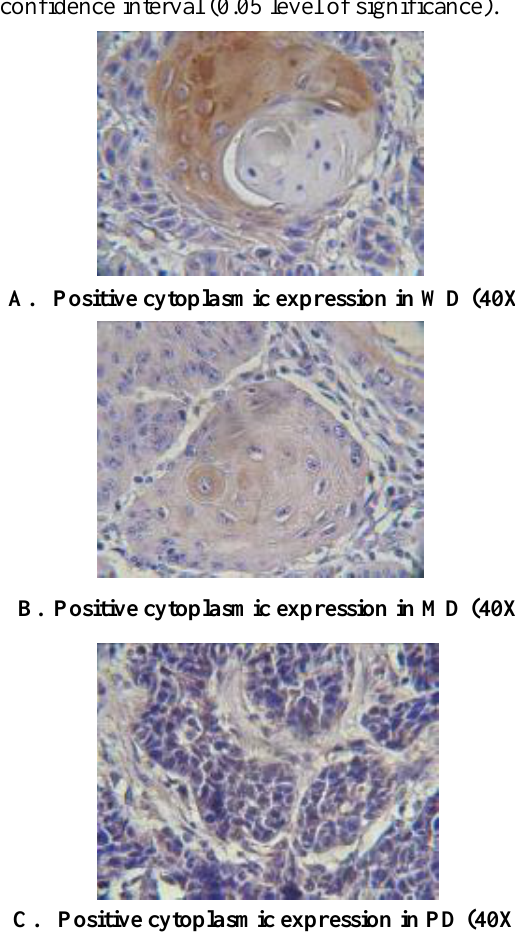
Immunohistochemical pattern of expression of